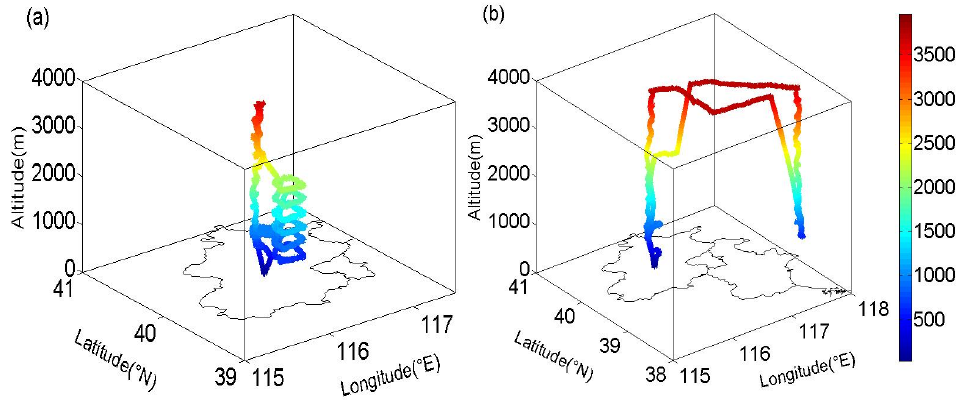
Figure 3. The major flight types used in this study. The first flight type ( a ) was